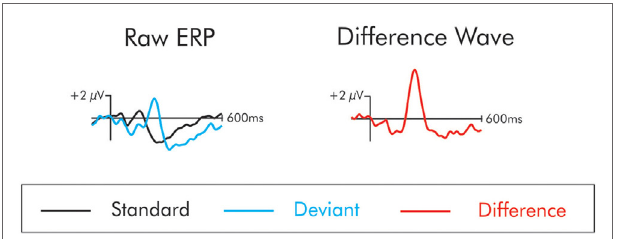
FigUre 1 | The “raw” event-related potentials (ERPs) following the presentation of the standard and deviant are traced on the left. The difference wave on the right is constructed by subtracting the raw standard from the deviant waveforms. The subtraction process removes the commonalities in processing between the standard and the deviant leaving only processing unique to the deviant. In the difference wave, a small negativity is apparent at about 100 ms. This is the mismatch negativity/deviant-related negativity. This deviant also elicits a large positivity at about 225 ms. This is the